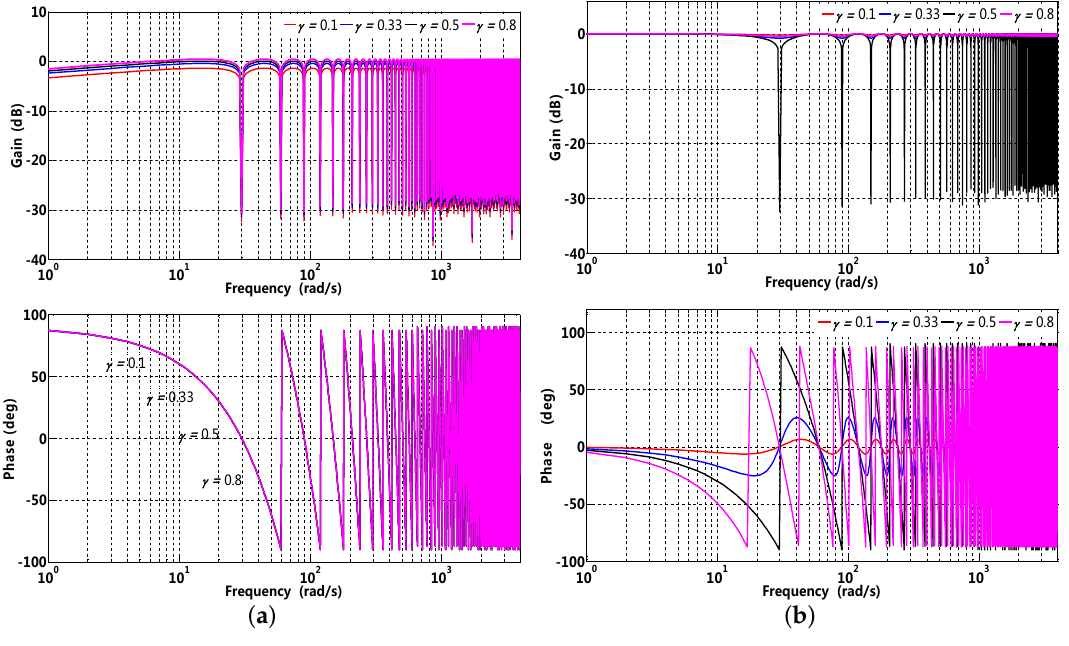
Figure 7. Frequency characteristics with respect to parameter γ : ( a ) 1 − Q ( z − 1 ) z − m ; ( b ) Q ( z − 1 )